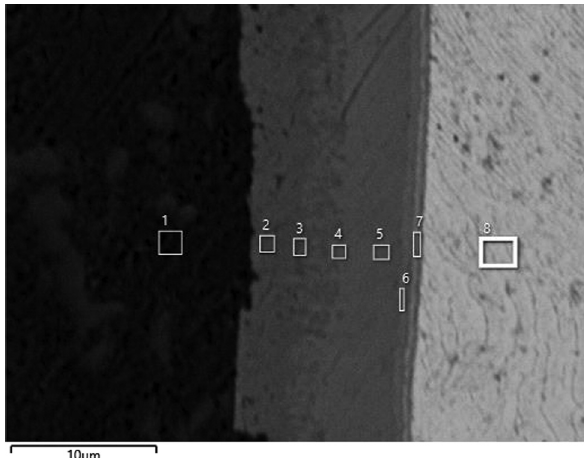
Figure 5: SEM micrograph of the interface of the steel/aluminum bimetallic castings with ultrasonic treatment taken from areas shown in Figure 4b and c.